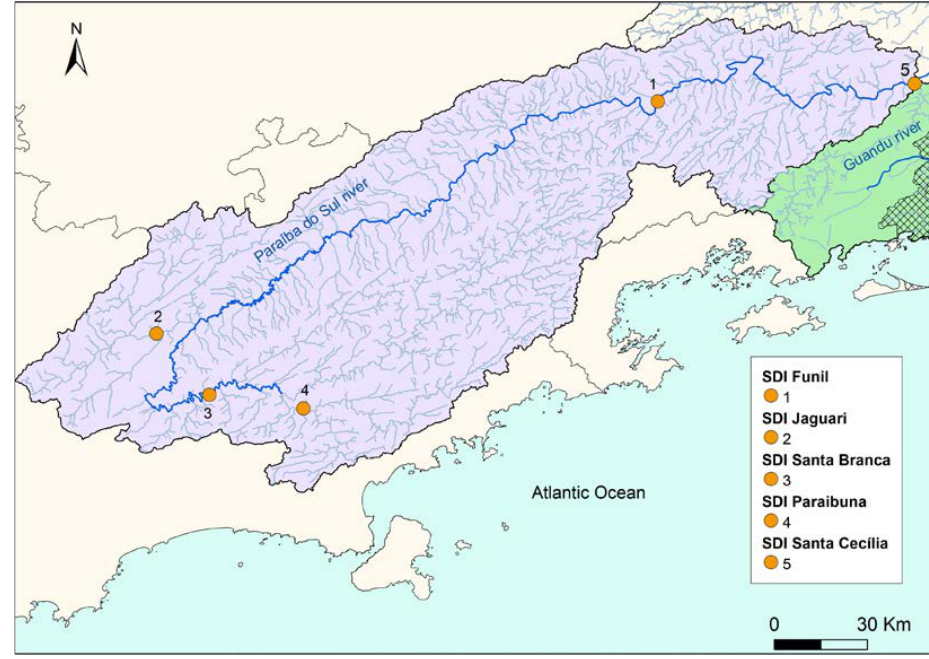
Figure 10. Monthly SDI in the basin’s reservoirs and Santa Cecília Dam (January 2015).